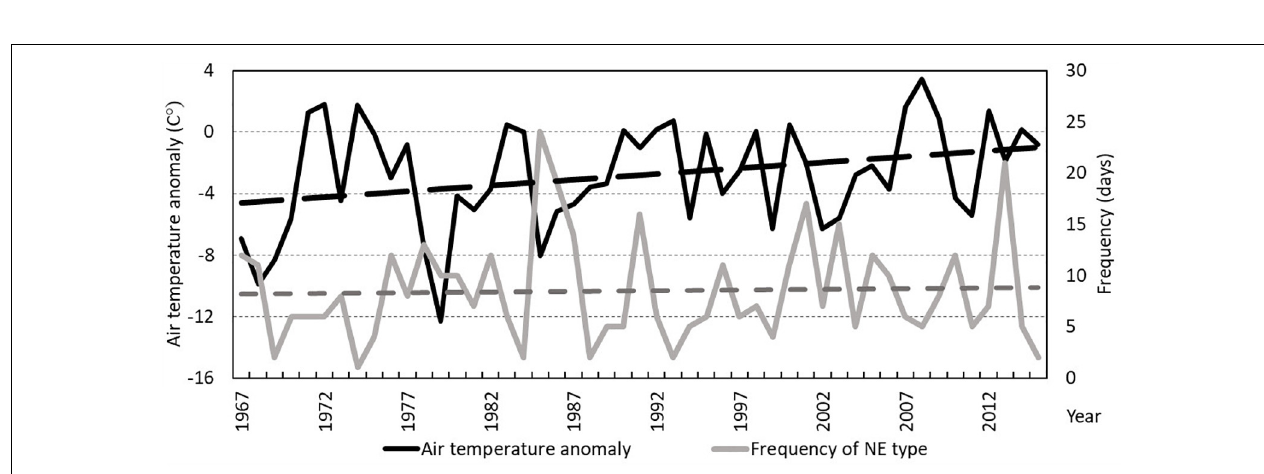
FIGURE 6 | Frequency of LIT09 classification circulation type NE and change by trend line in days in winter (1967–2015). And long-term average air temperature anomaly associated with circulation types at Türi station and changes by trend line in ◦ C in winter.